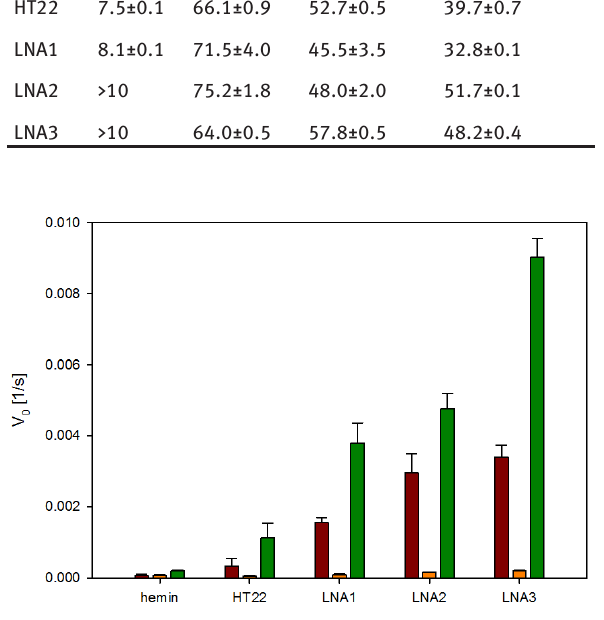
Figure 8: Catalytic activity of HT22 and LNA-modified DNAzymes in the reaction of ABTS oxidation by hydrogen peroxide. Color code: brown- potassium, orange-sodium, green-ammonium cations. Conditions: 10 mM Tris-HCl (pH=8.0), 100 mM KCl, NaCl or NH